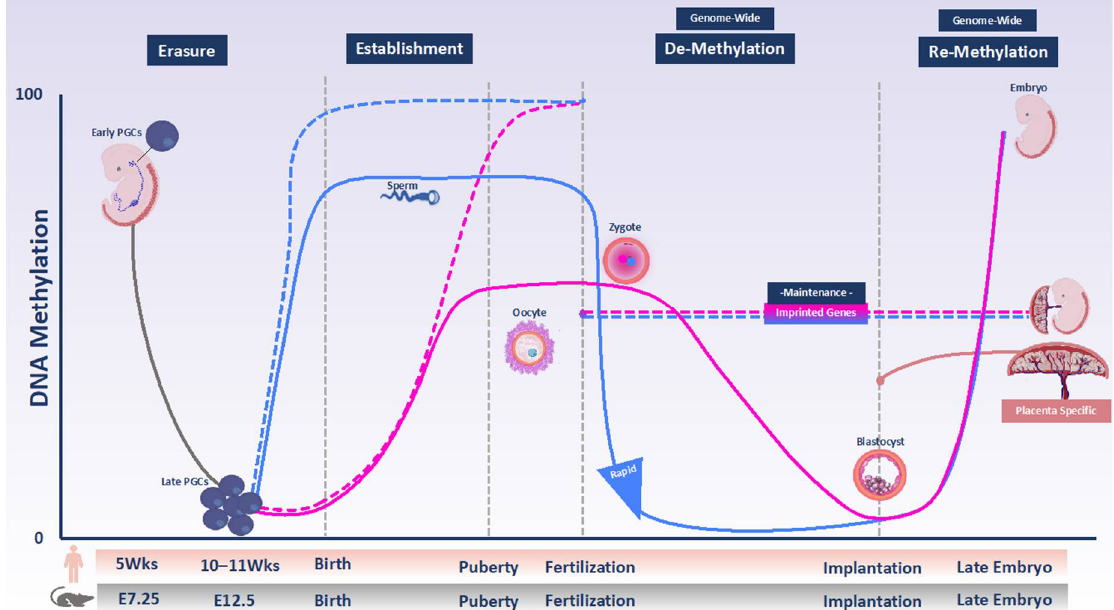
Figure 1. DNA methylation programming and reprogramming during development in humans and mice. DNA methylation is globally erased in primordial germ cells (PGCs) derived from epiblast during their proliferation and migration to the genital ridges (solid gray line). Therefore, de novo DNA methylation subsequent takes place on a largely blank slate during male and female gametogenesis. In the male, new methylation is established from soon after demethylation and is almost completed by the time of birth (solid blue line). In females, there is no gain of methylation until after birth. Growing oocytes arrested in the first meiosis prophase gain methylation between birth and puberty, as well as in adult life (solid pink line). Maternally and paternally imprinted DMRs become differentially methylated in gametes over the same time window (dashed pink and blue lines, respectively). After fertilization, the parental genomes undergo genome-wide demethylation, which does not include imprinted DMRs (dashed combined pink and blue lines). The timing and extent of demethylation are different for the two parental genomes. The paternal genome is rapidly demethylated in part via TET proteins activity (solid blue line). The maternal genome is protected against TET activity and undergoes passive demethylation following DNA replication (solid pink line). By the time of implantation, the genome–except for imprinted DMRs–undergoes re-methylation events that are necessary for cell-lineage determination (combined red and blue lines). Placenta-specific imprinting that is present only in humans is shown with the solid coral orange